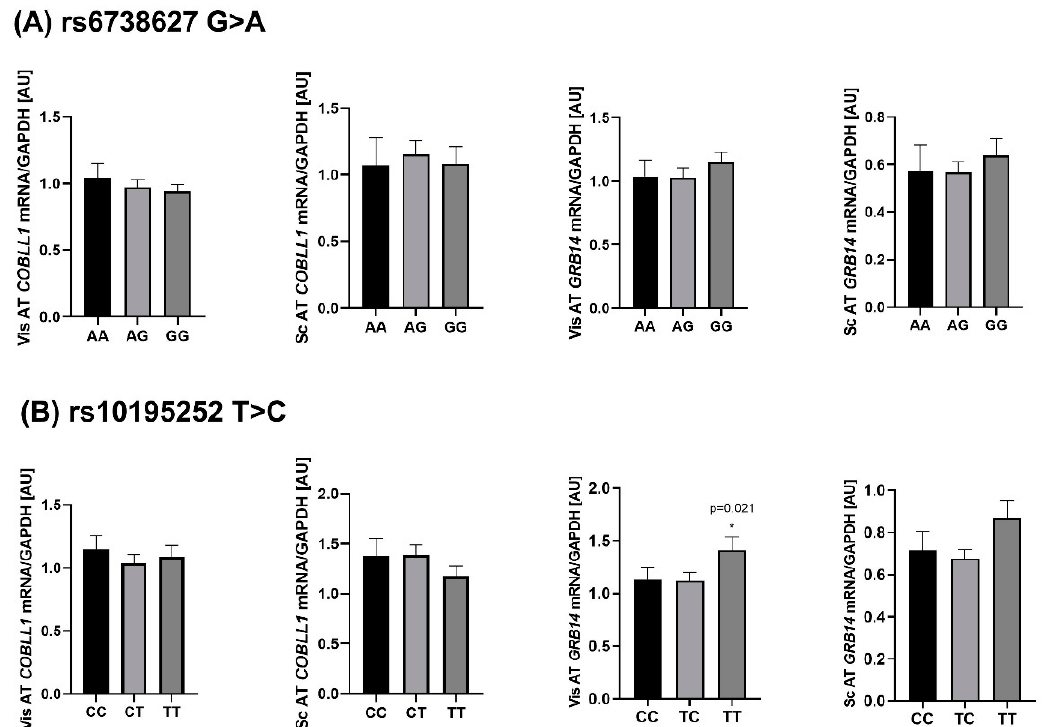
Figure 6. Association of rs6738627 and rs10195252 with COBLL1 and GRB14 mRNA expression in visceral (vis) and subcutaneous (sc) AT. ( A ) shows the rs6738627 associated with COBLL1 and GRB14 mRNA expression in both ATs. ( B ) shows the rs10195252 associated with COBLL1 and GRB14 mRNA expression in both ATs. Data are given as arithmetic mean ± SEM; p < 0.05 in additive mode of inheritance; adjusted for sex, age, BMI.